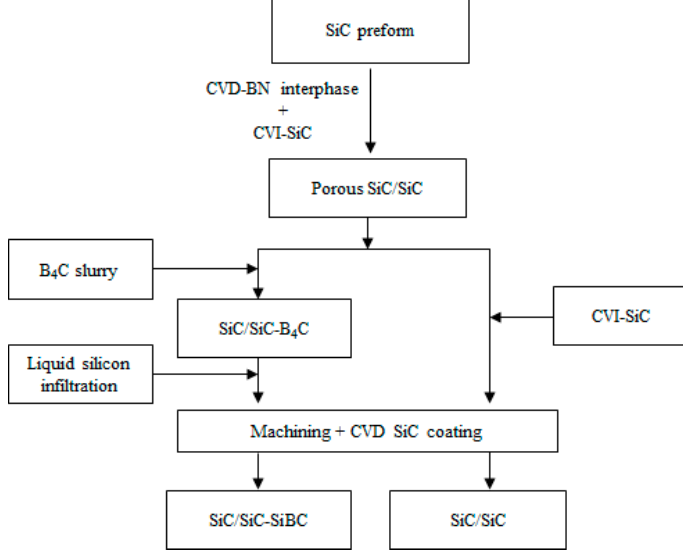
Figure 1. Schematic for the fabrication of SiC fiber-reinforced silicon carbide matrix composite (SiC/SiC) and self-healing Si-B-C matrix modified ZMI-SiC fiber/SiC (SiC/SiC-SiBC).